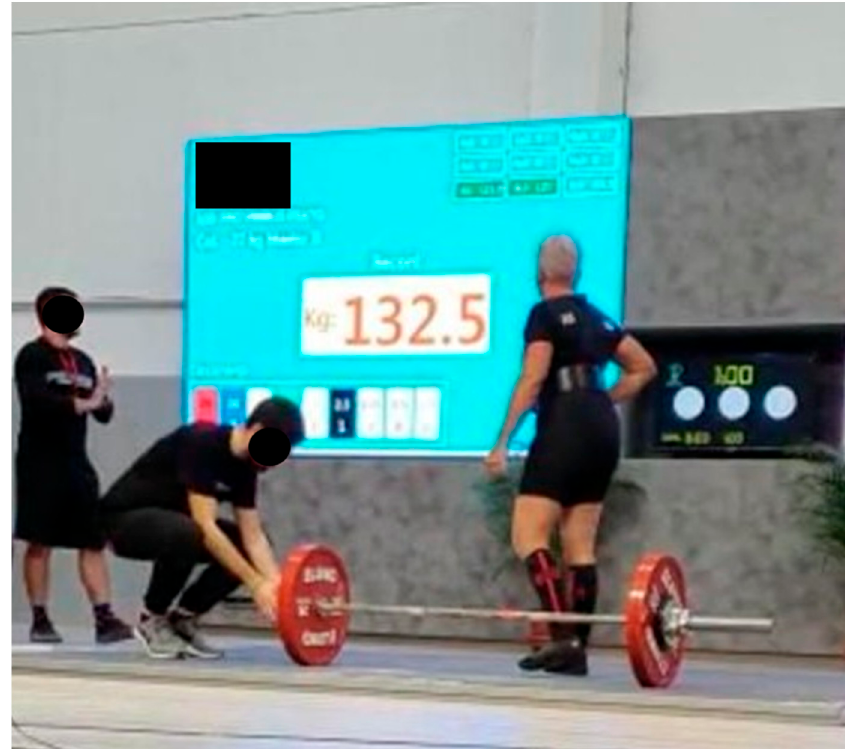
Figure 3. Italian deadlift championship. The AxSpA patient achieved the Italian record with 132.5 kg.